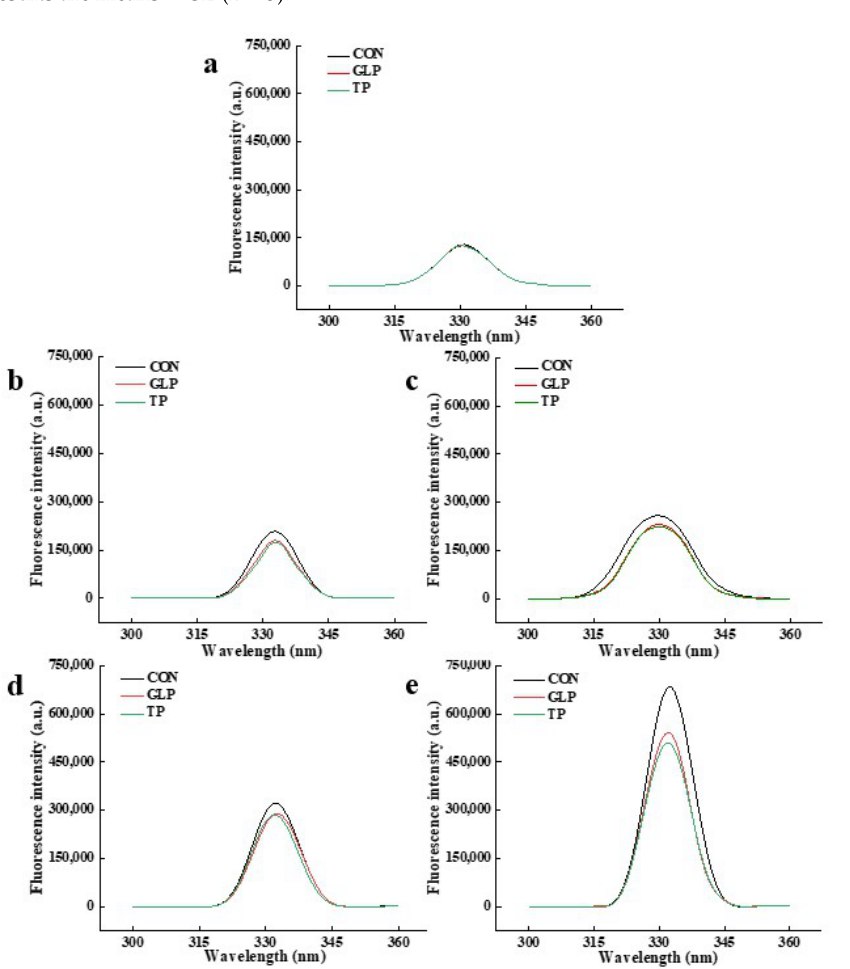
Figure 5. Effect of guava leaf polyphenols on the pentosidine content of frozen chicken meatballs. ( a – e ) indicate chicken meatballs are frozen for 0, 1, 2, 3, and 6 mon, respectively. GLP, guava leaf polyphenols; TP, tea polyphenol; CON, control.